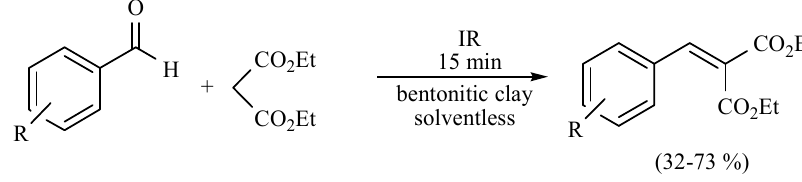
Scheme 1. Synthesis of benzylidenemalonates.